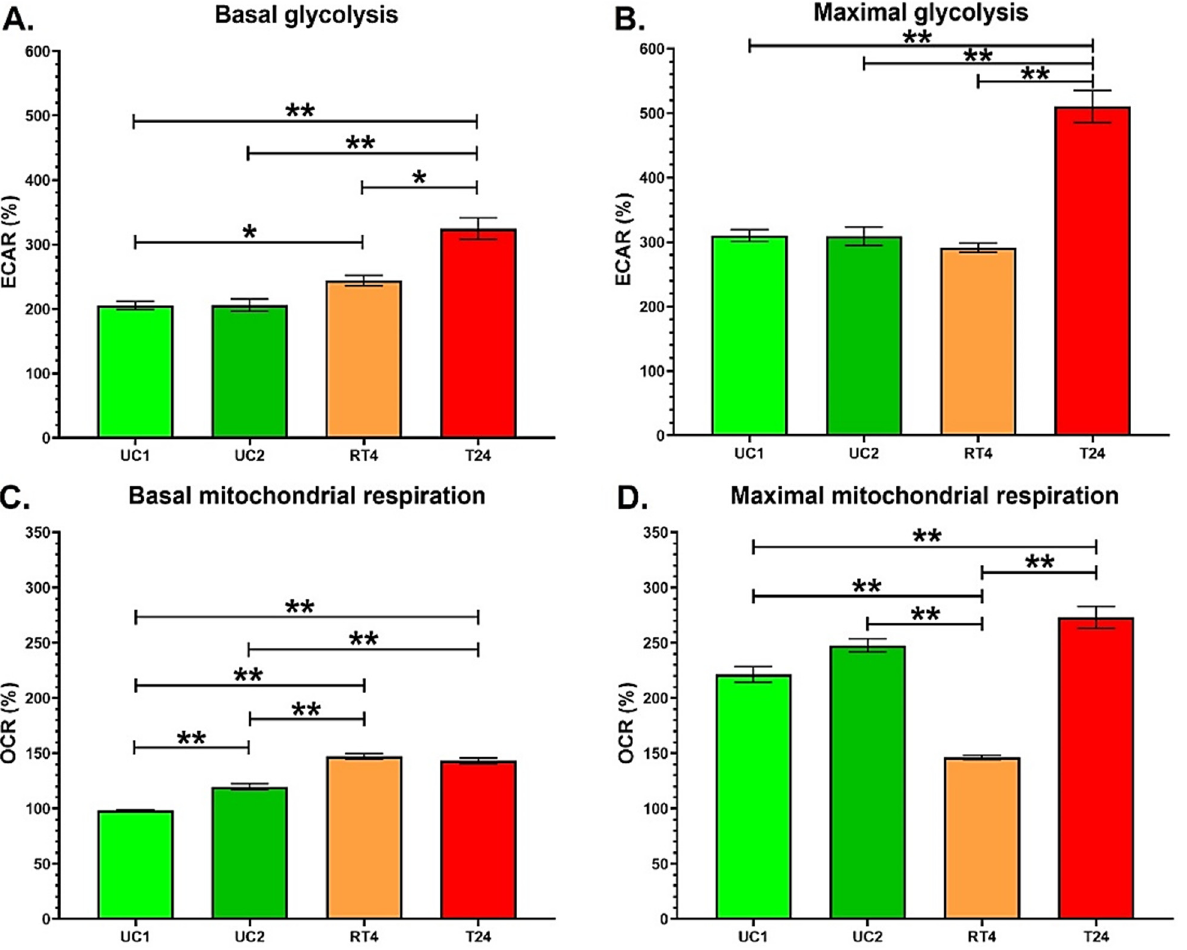
Figure 1. T24 invasive bladder cancer cells exhibit an increased glycolytic capacity compared with RT4 non-invasive bladder cancer cells. ( A , B ) ECAR and ( C , D ) OCR were determined using the XFe96 Extracellular Flux Analyzer in two populations of normal urothelial cells (UC1 and UC2) and non-invasive (RT4) and invasive (T24) bladder cancer cells to establish ( A ) basal glycolysis, ( B ) maximal glycolytic capacity, ( C ) basal mitochondrial respiration and ( D ) maximal mitochondrial capacity. Data are presented as the mean ± SEM and displayed as percentages of UC1 acting as control (n = 10, N = 4). A baseline (100%) was established before injections (see Figure S1). * p < 0.05, ** p < 0.01 by Kruskal–Wallis test.